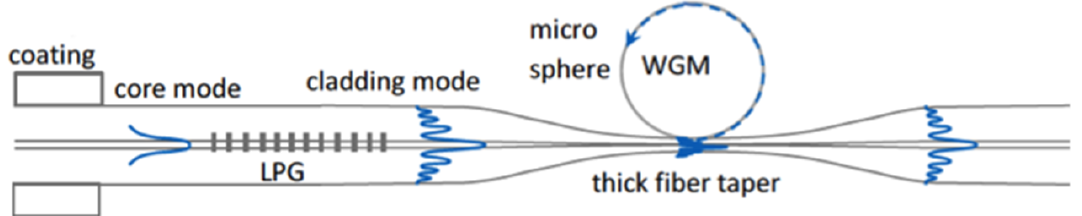
Figure 6. Sketch of a long period fiber grating (LPG) exciting the cladding mode followed by a ‘thick’ taper where coupling with the resonator takes